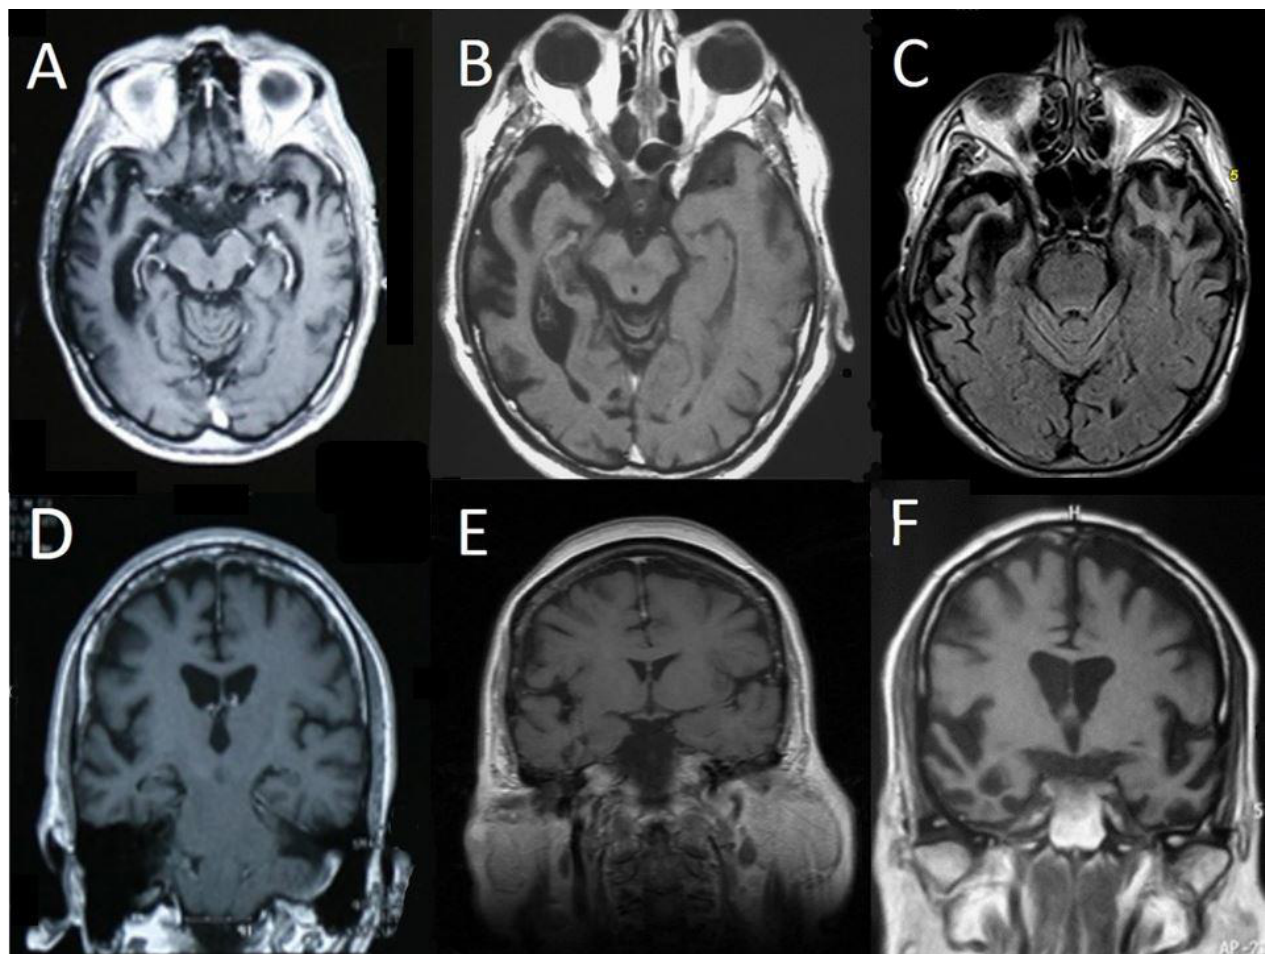
Figure 1. Representative Magnetic Resonance Imaging (MRI) scans of 6 patients from the right temporal variant of frontotemporal dementia (rtv-FTD) group. T1 axial ( A , B ) and fluid attenuated inversion recovery (FLAIR) ( C ) scans show severe right anterior temporal lobe atrophy with milder involvement of the left temporal lobe. T1 coronal ( D , E ) scans show a less pronounced but predominant right temporal lobe atrophy, whereas scan ( F ) shows bilateral involvement with predominant right temporal lobe atrophy.